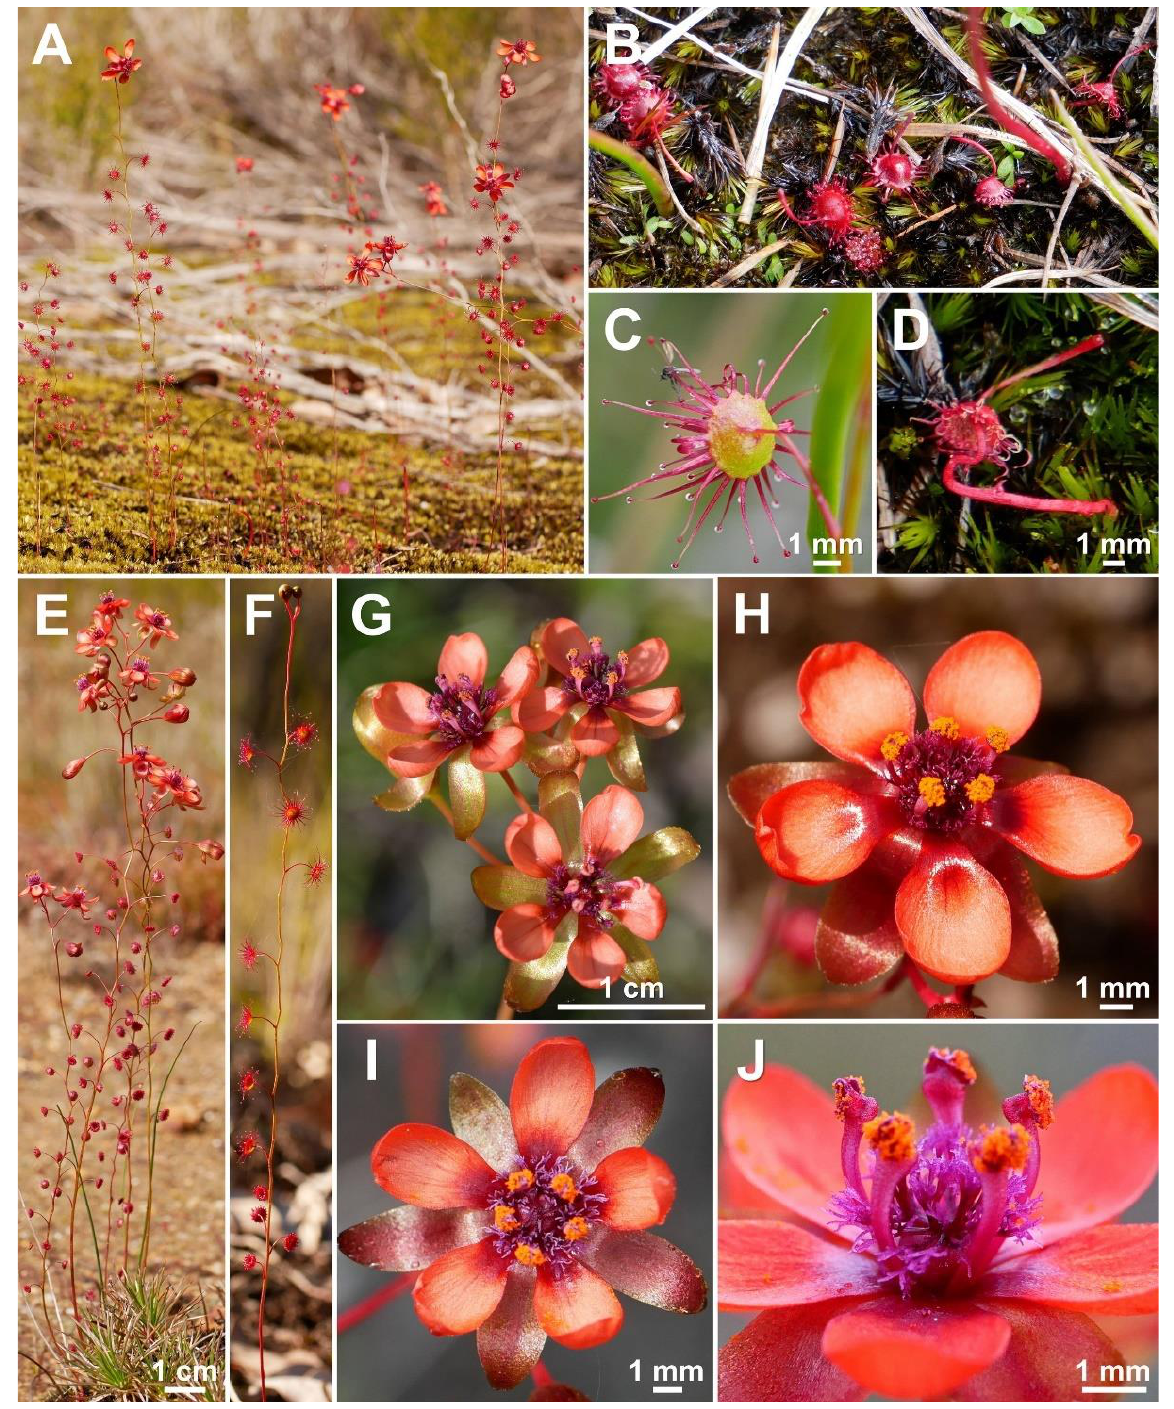
Figure 14. Drosera microphylla Endl. ( A ) group of plants; ( B ) detached leaves; ( C ) lamina, abaxial view; ( D ) detached leaf with adventitious dropper shoot emerging from central adaxial side of the lamina; ( E ) habit of a group of flowering plants; ( F ) habit of a single plant with developing flower buds, note the large leaf-free gaps along the stem due to detached leaves; ( G , H ) flowers in bright sunlight; ( I ) flower in diffuse light; and ( J ) stamens and styles. ( A , E , H ) from near Kentdale, Western Australia, 26 August 2022. ( B , D ) from near Denmark, Western Australia, 15 September 2021. ( C , I , J ) from Mount Frankland North National Park, Western Australia, 13 September 2021. ( F ) from near Walpole, Western Australia, 25 August 2022. ( G ) from near Denmark, Western Australia, 4 September 2014. Images: T. Krueger.